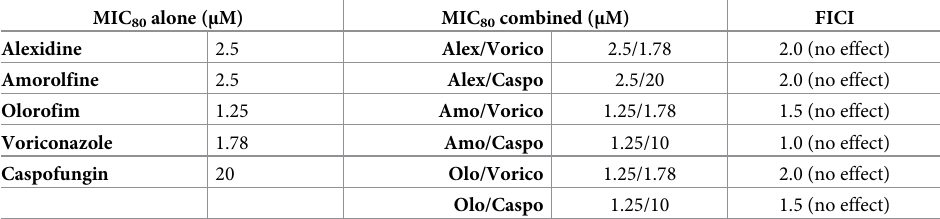
MIC: Minimal inhibitory concentration. FICI: Fractional Inhibitory Concentration Index. Alex: Alexidine. Amo: Amorolfine. Olo: Olorofim. Vorico: Voriconazole. Caspo: Caspofungin. Experiments were performed in triplicate, in three independent experimental